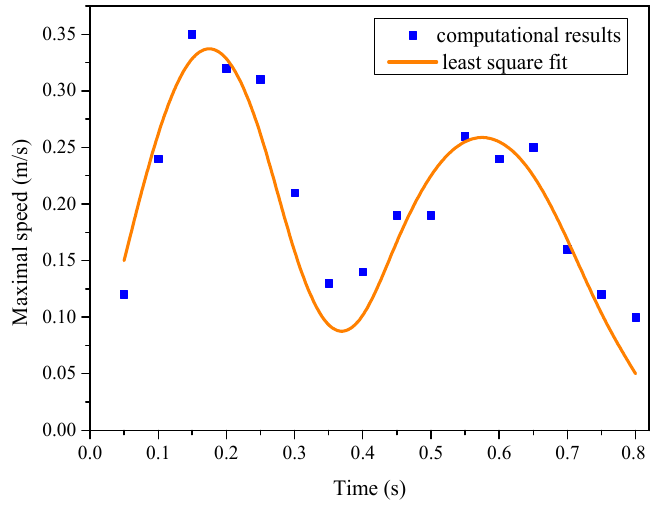
Figure 5. Temporal evolution of the maximal velocity.